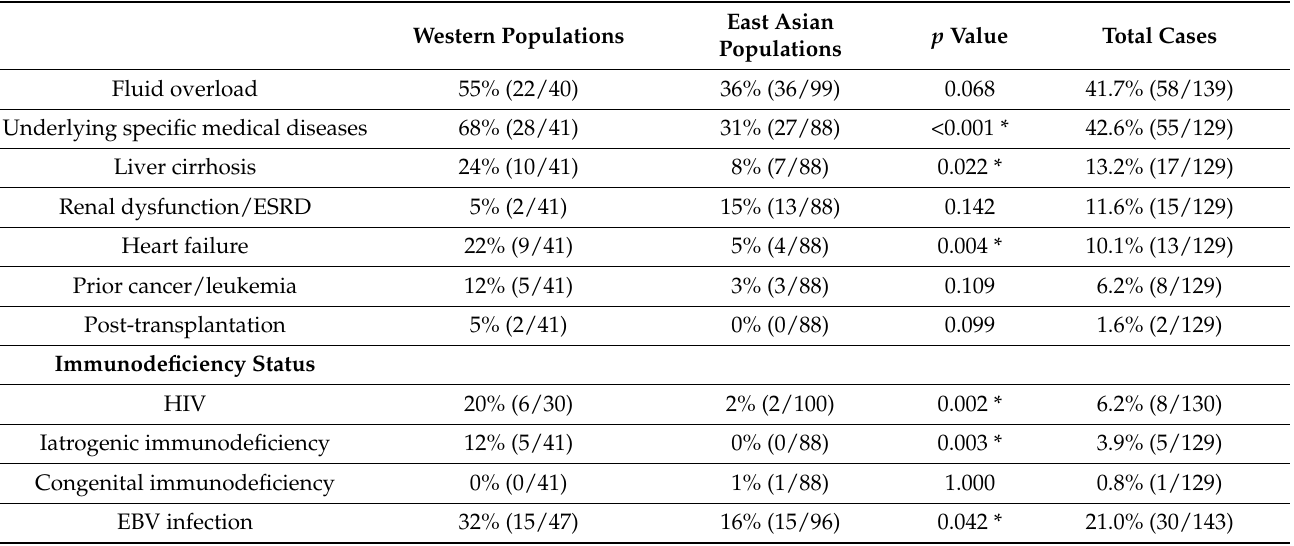
Table 3. The comparison of main clinicopathological characteristics of HHV8-negative type II PEL patients between Western and Eastern Asian